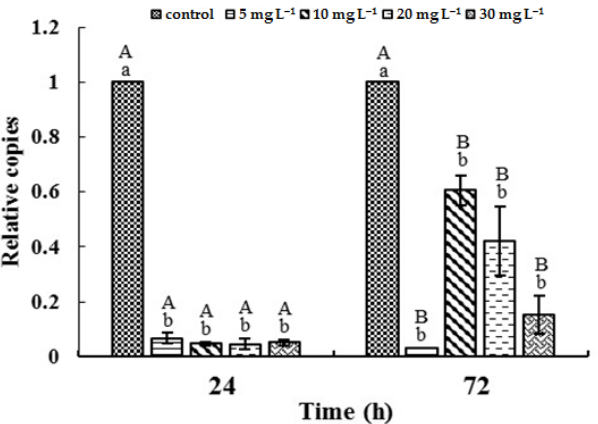
Figure 5. Effects of increasing [Hmim]Cl concentrations on the transcription of mcyB gene. Different uppercase letters represent significant differences ( p < 0.05) between exposure times within the same treatment. Different lowercase letters represent significant differences ( p < 0.05) between treatments within the same exposure time.